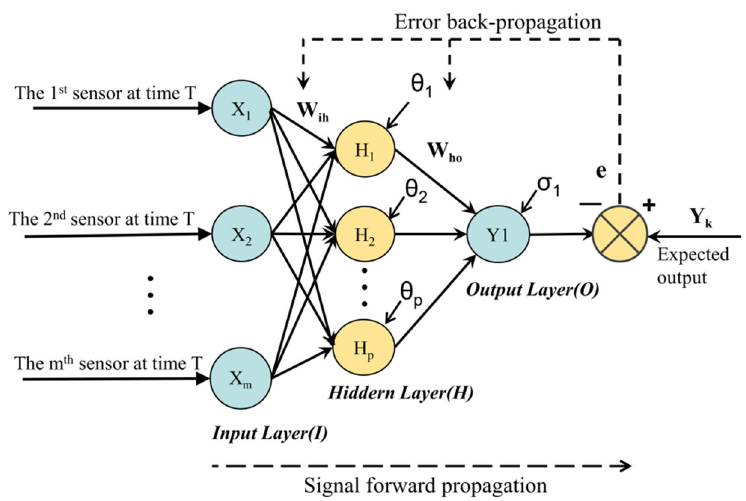
Figure 7. Basic structure of sensor data reconstruction based on BP neural network.